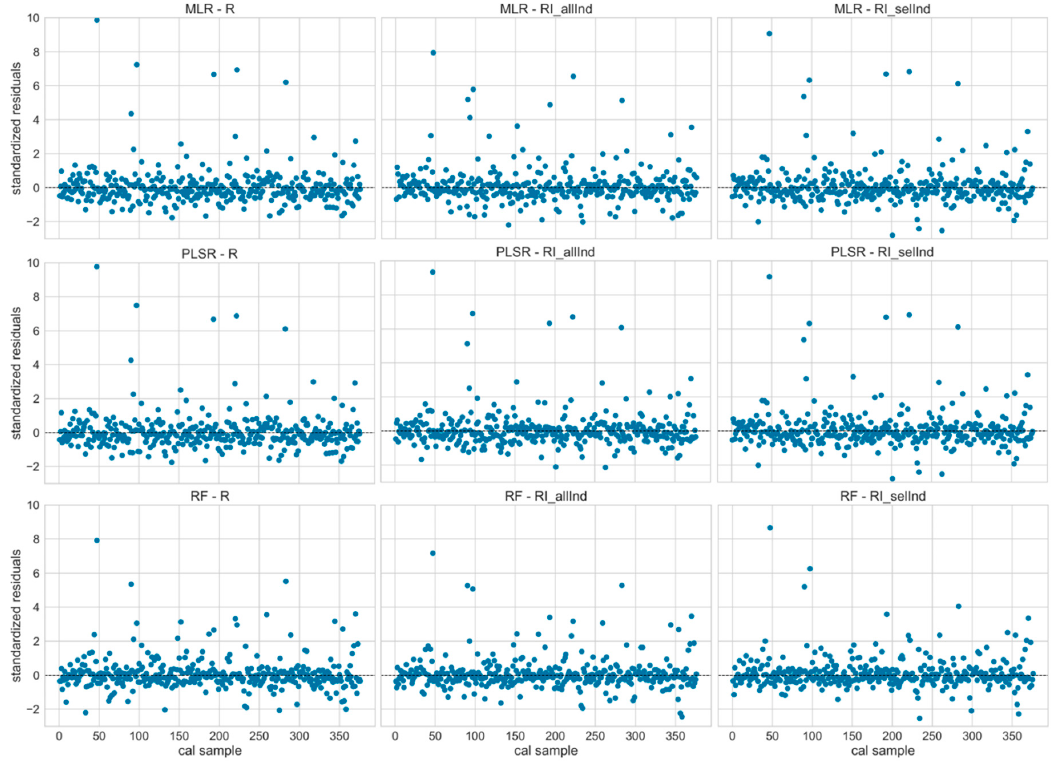
Figure A2. Standardized residuals of the model validation (30% of data points).